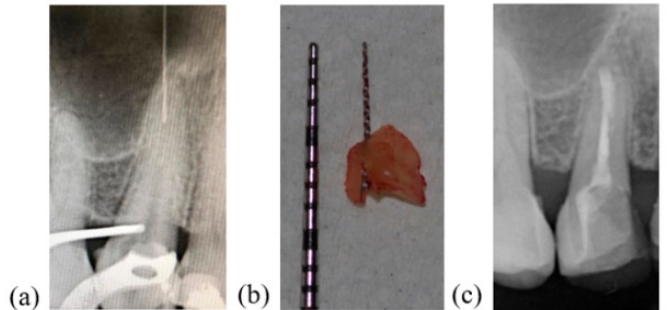
Figure 4. Micro apical surgery of the maxillary premolar. ( a ) Initial radiograph after instrument fracture, ( b ) size of the resected apex and of the removed instrument and ( c ) postoperative radiograph at one year.